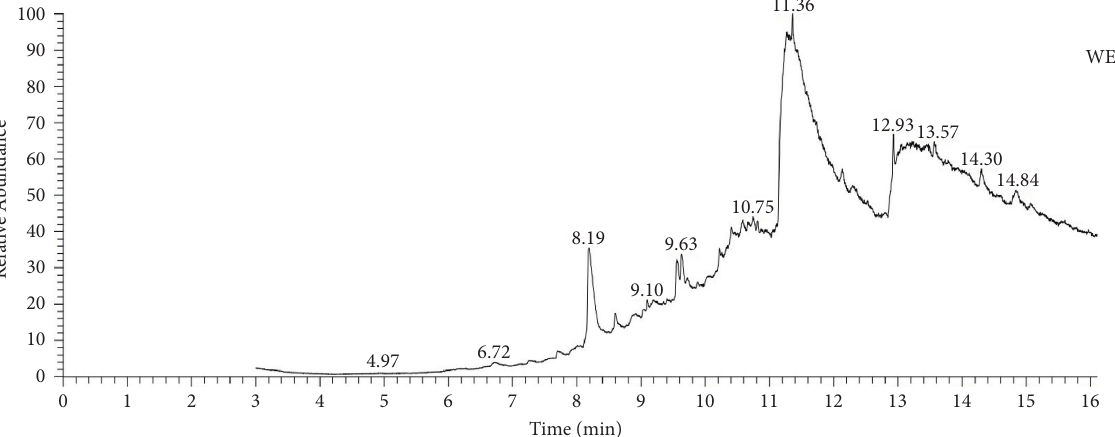
Figure 5: GC-MS chromatogram of